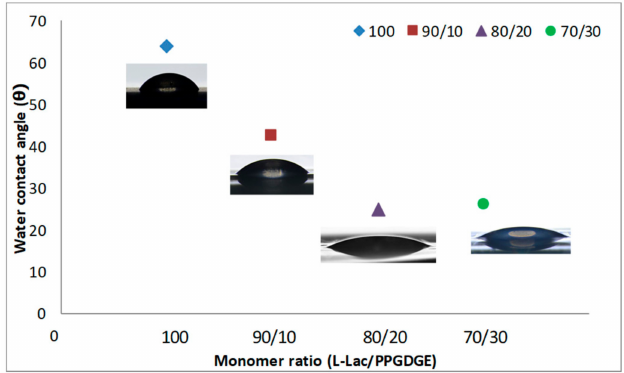
Figure 7. Contact angle of PLA-co-PPGDGE by varying monomer ratio. cat/ini ratio 0.01/0.15 wt %.